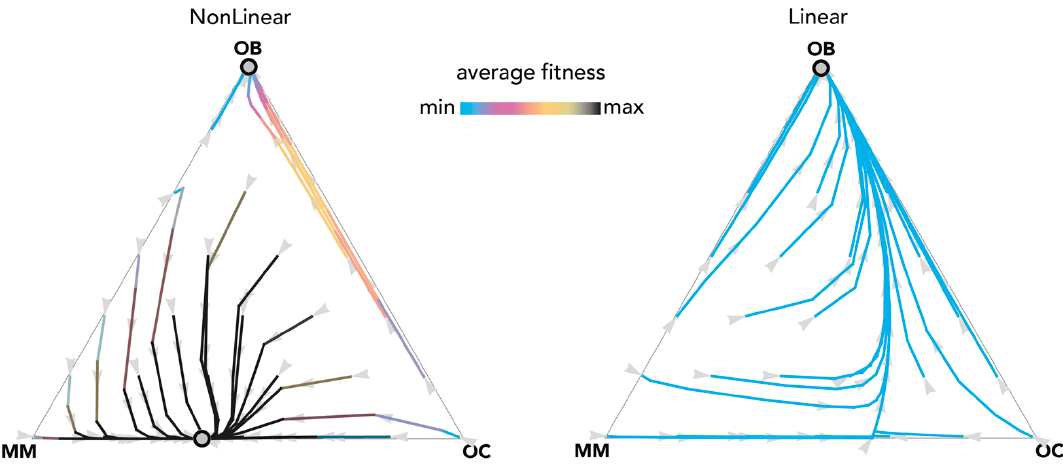
Figure 4. Nonlinear benefits can lead to an additional mixed equilibrium on the MM–OC edge. The distance from each vertex is inversely proportional to the frequency of each type. Arrows show the direction of the dynamics; colors show the average fitness of the population. N = 20; c OC = 1.5; c OB = 0.5; c MM = 2; B OC,OC = 0.6; B OC,OB = 1.1; B OC,MM = 2.3; B OB,OC = 1; B OB,OB = 0.5; B OB,MM = 0; B MM,OC = 3; B MM,OB = − 0.5; B MM,MM = 1.5; h OC,OC = 0; h OC,OB = 0; h OC,MM = 0; h OB,OC = 0; h OB,OB = 0; h OB,MM = 0; h MM,OC = 0.3, h MM,OB = 0.5; h MM,MM = 0.1. Nonlinear: s OC,OC = 10; s OC,OB = 10; s OC,MM = 100; s OB,OC = 10; s OB,OB = 10; s OB,MM = 20; s MM,OC = 10; s MM,OB = 10; s MM,MM = 100; Linear: s i,j → 0.